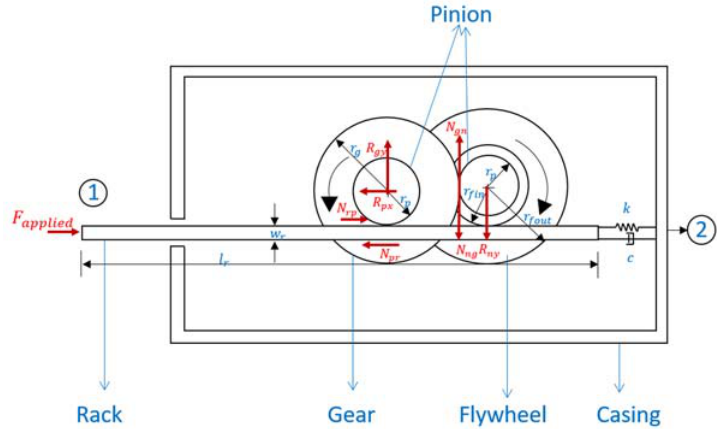
Figure 17. Line diagram of rack and pinion inerter with lumped elements representing the internal stiffness and damping.